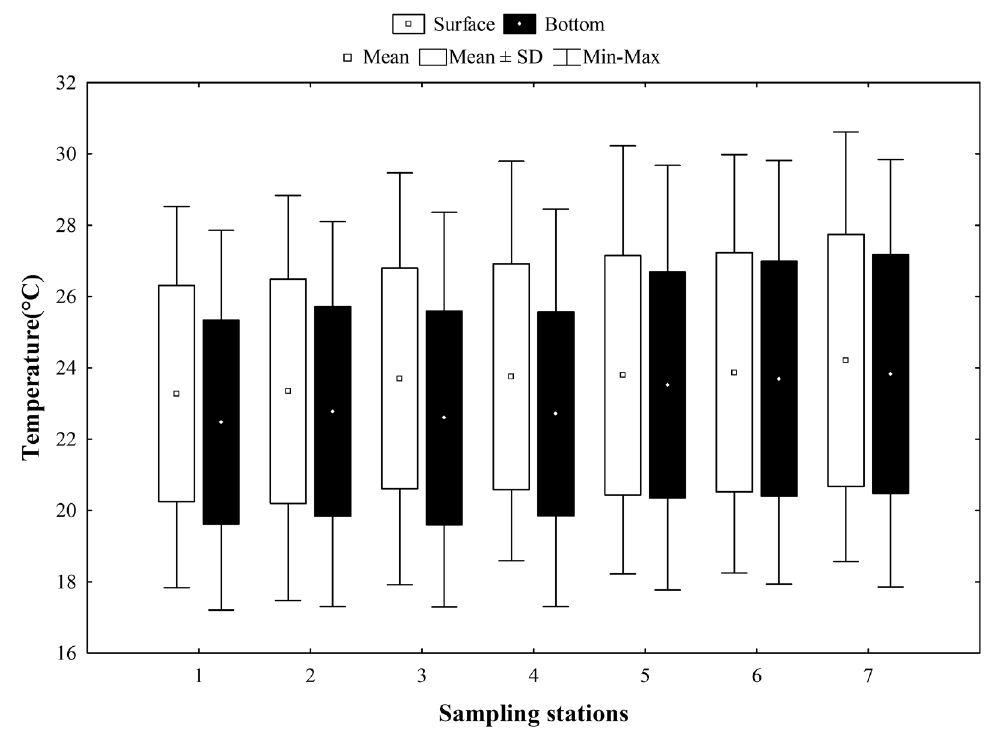
Figure 3. Spatial variation of temperature of surface and bottom water, from July/2012 to June/2014, in Cananéia region, Brazil (Mean; SD = standard deviation; Min = minimum; Max = Maximum).